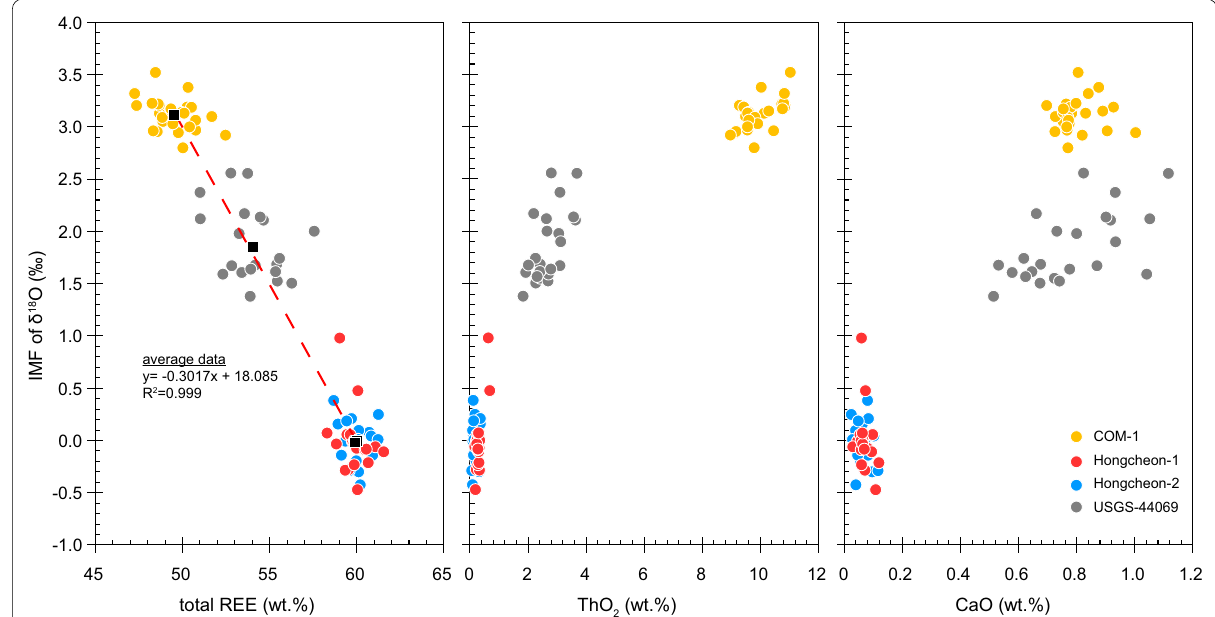
Fig. 3 Secondary ion mass spectrometry δ 18 O values plotted against inductively coupled plasma mass spectrometry‑based total rare